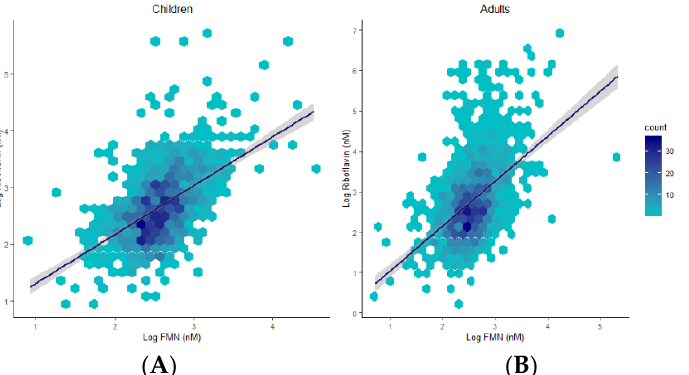
Figure 4. Hexagonal plots and trends of associations between riboflavin and FMN in children ( A ) and adults ( B ).